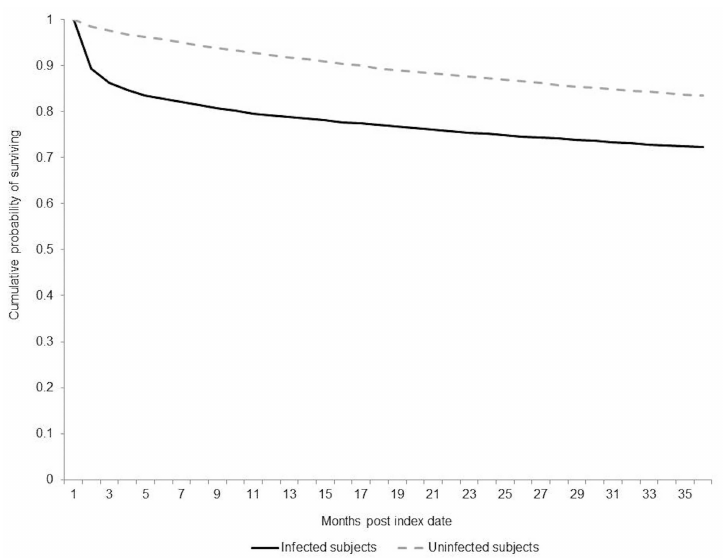
Fig 1. Survival curve for infected subjects and their matched pairs, three yearspost index date.